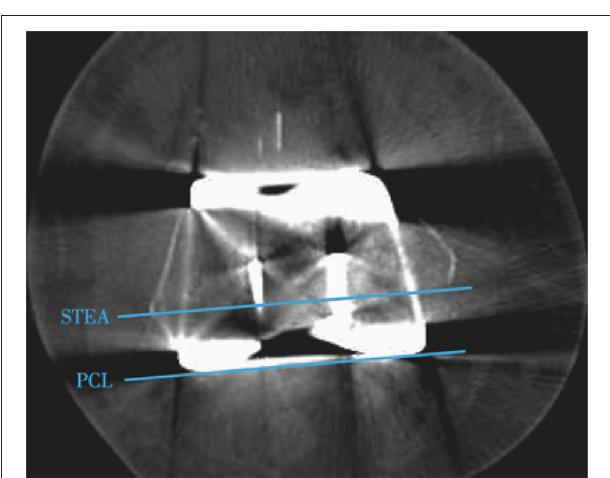
FIGURE 2 | Postoperative CT of knee. The STEA (surgical transepicondylar axis) represents the axis of rotation of the original femur of the knee, while the PCL (posterior condyle line) of the prosthesis can be regarded as the axis of rotation of the prosthesis. The femoral prothesis rotation angle reflects the difference of the femoral prosthesis rotation axis with the surgical transepicondylar axis.